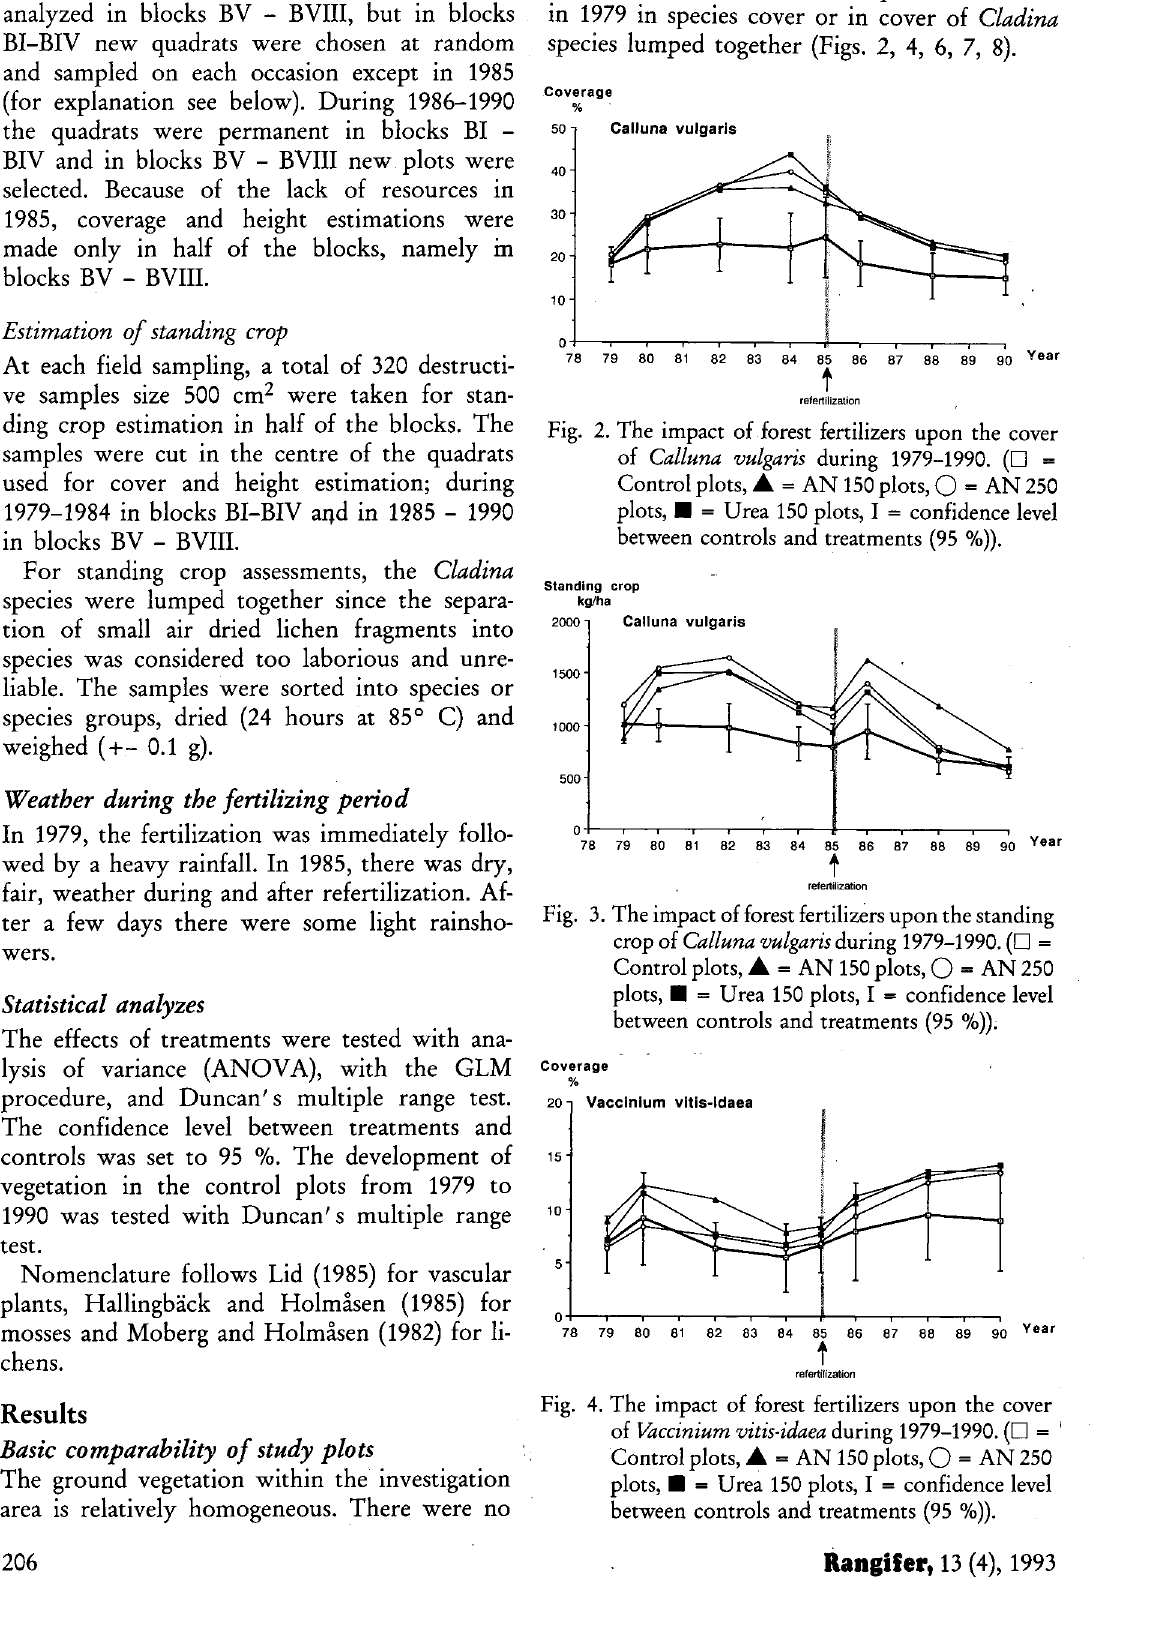
Fig. 4. The impact of forest fertilizers upon the cover of Vaccinium vitis-idaea during 1979-1990. (• = 1 Control plots, A = AN 150 plots, O = AN 250 plots, • = Urea 150 plots, I = confidence level between controls and treatments (95